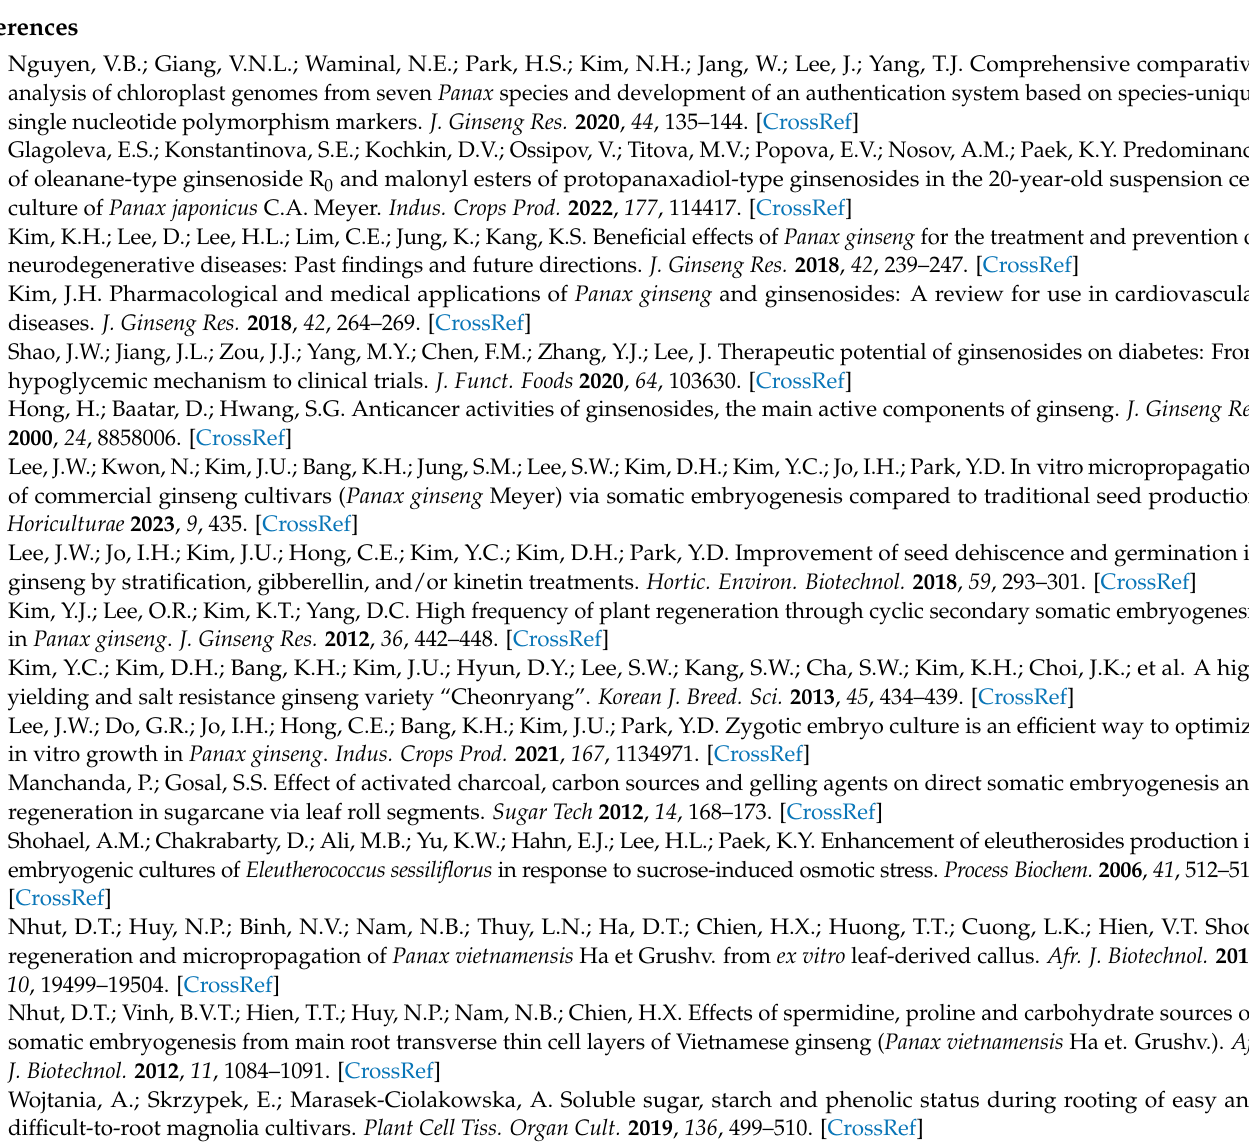
upper: 1 cm; lower: 1 mm. Figure S3: Plant regeneration according to sucrose concentration in the germination medium 60 days after transfer to elongation medium. (A) 1%, (B) 2%, (C) 3%, and (D) 4% sucrose. Scale bars, 1 cm. Table S1: List of primers used for detecting the genetic stability of plants regenerated from somatic embryogenesis of P. ginseng